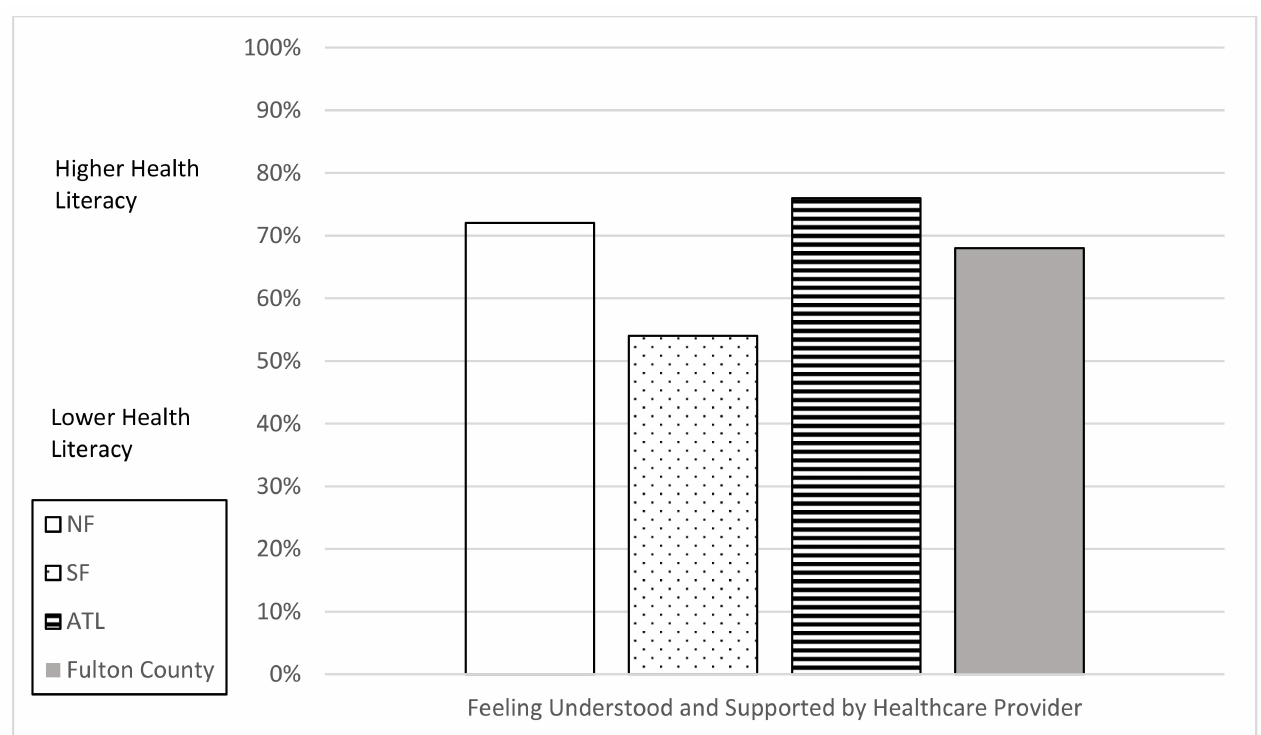
Figure 2. Individual Health Literacy Scale (cut point 60%) by County Area: Engage with Providers, Find Health Information, Understand Health Information. Based on Level of Difficulty (lower = cannot do/very difficult/quite difficult; higher = easy/quite easy).